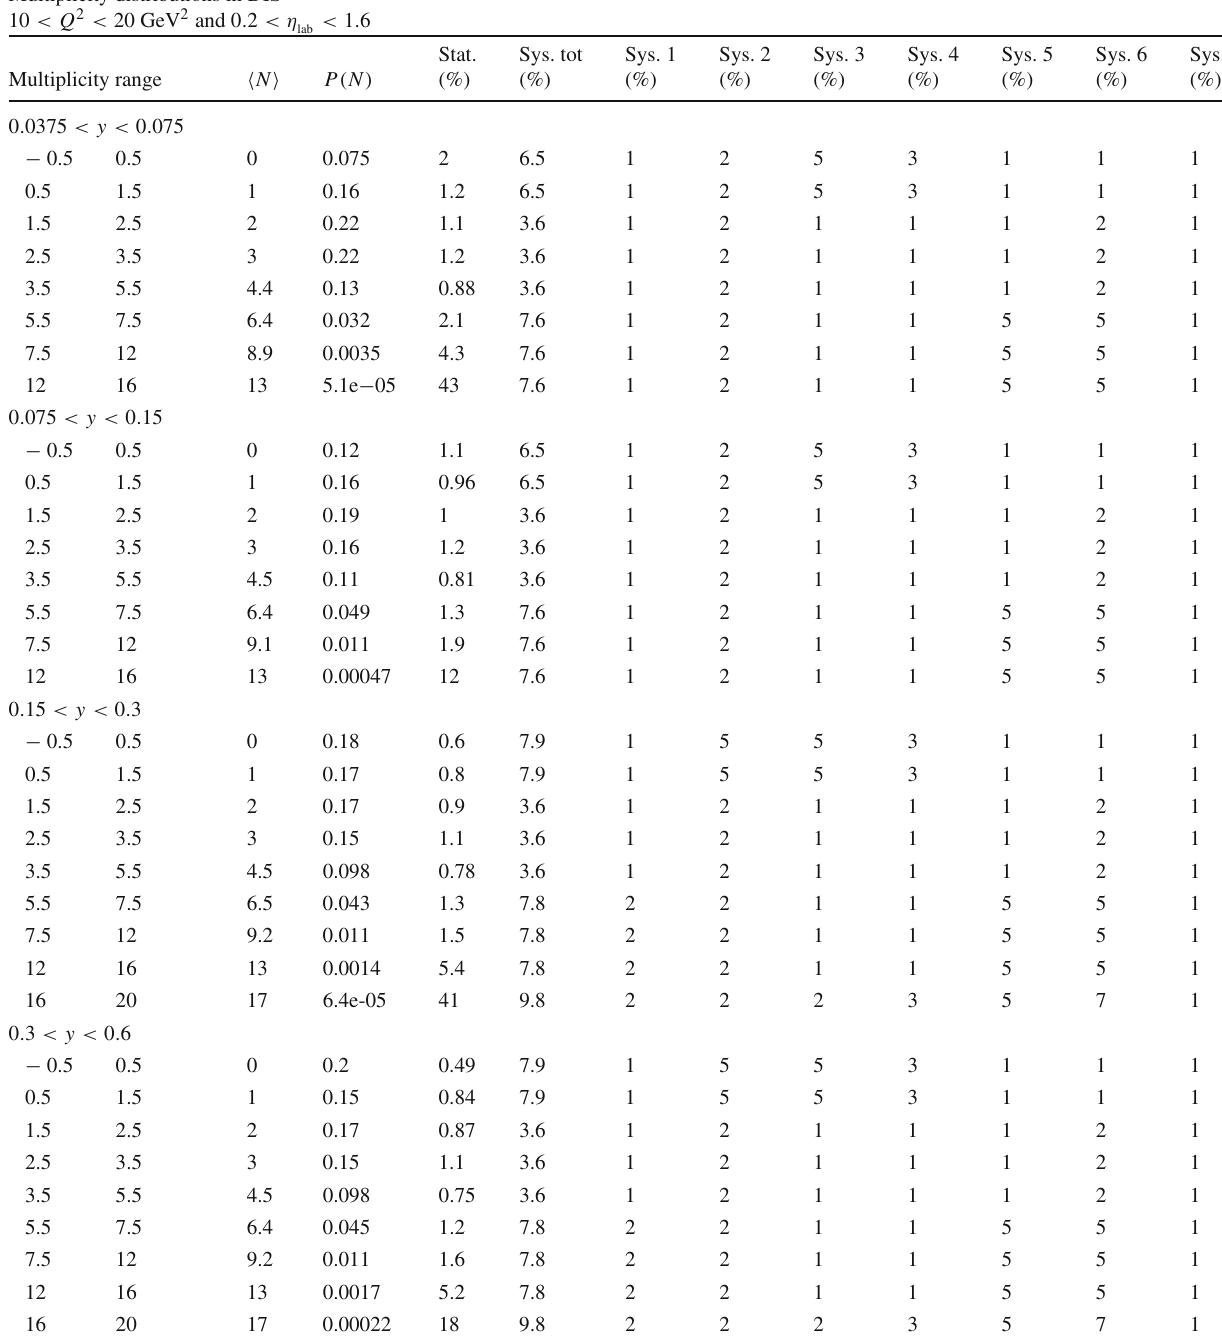
Table 18 Charged particle multiplicity distributions P ( N ) measured √ s = 319GeV with in the ranges of photon virtual- in ep DIS at ity 10 < Q 2 < 20 GeV 2 and charged particle pseudorapidity range Multiplicity distributions in DIS < 1 . 10 < Q 2 < 20 GeV 2 and 0 . 2 < η lab